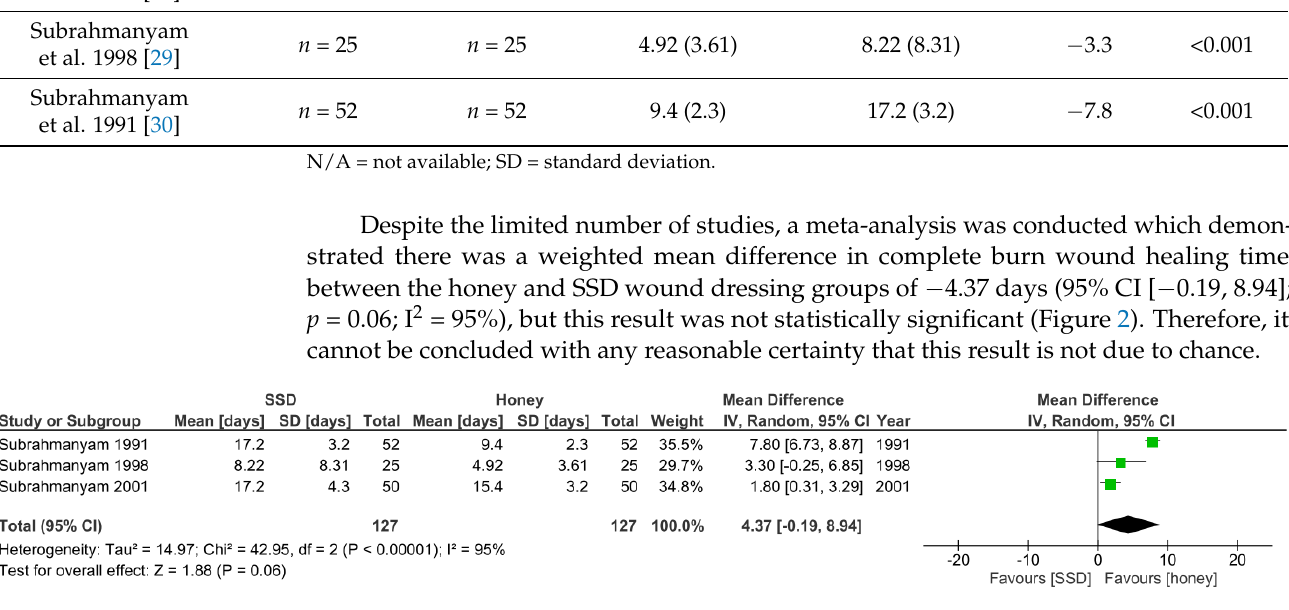
Figure 2. Forest plot of mean difference in complete burn wound healing time between honey and SSD burn dressing groups. Green squares = weighted mean difference. Black diamond = overall weighted mean difference.